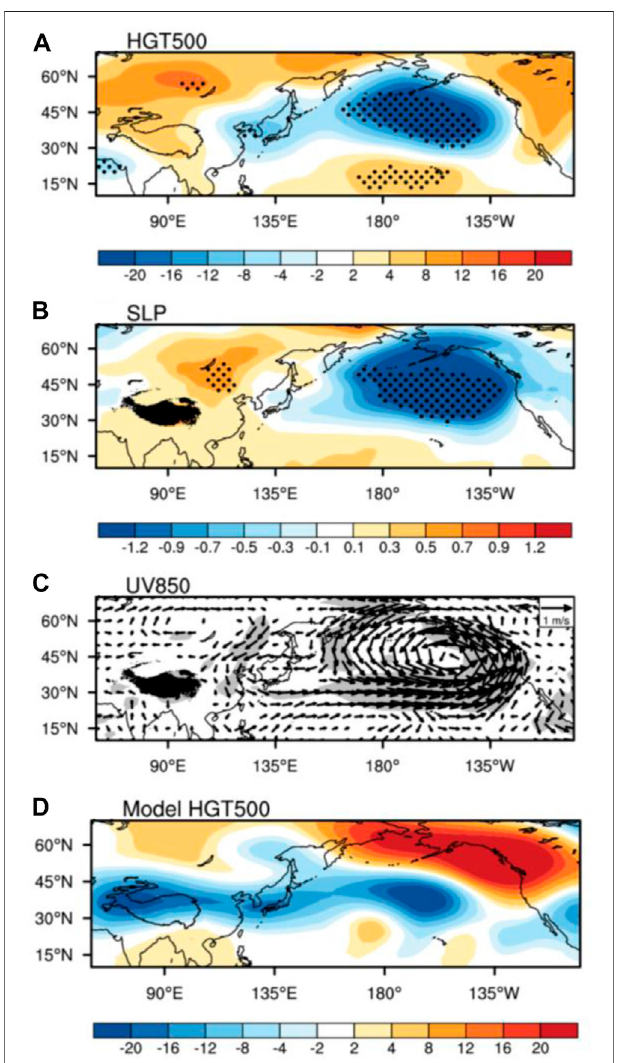
FIGURE 4 | Interannual anomalies of winter (A) 500 ° hPa geopotential height (m), (B) SLP (hPa) and (c) 850 ° hPa wind (ms − 1 ) obtained by regression on the ONDJ TP SCI for the period 1979 – 1998. (d) Difference of winter 500 ° hPa geopotential height (m) between the sensitivity experiment and control experiment based on the last 14-years simulations of the CAM model. The wind vector scale is shown on the top-right corner in (C) . The dotted regions in (A, B) and the shaded regions in (C) denote that anomalies of geopotential height in (A) , SLP in (B) and either u wind or v wind in (C) are signi fi cant at the 95% con fi dence